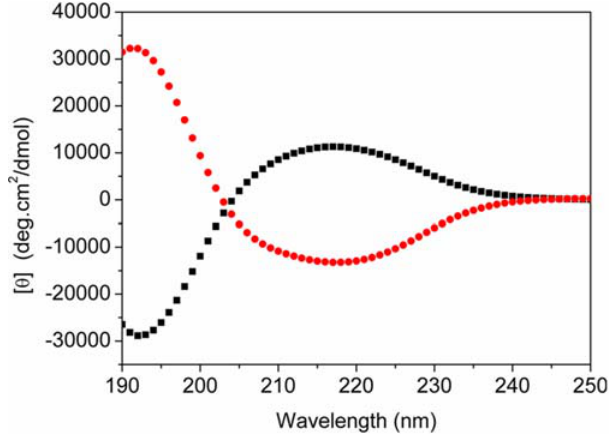
Figure 2. Circular dichroism spectra of peptides d-EAK16 and l- EAK16 were in water at 25 u C. X-axis is wavelength in nm and Y-axis is expressed as mole residue ellipticity [ h ]. The mirror images of d-EAK16 and l-EAK16 reflect the molecular